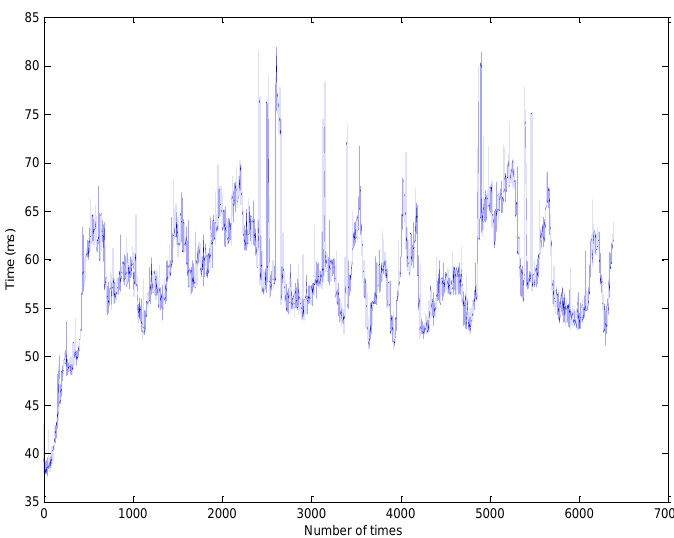
Figure 16. The execution time of our